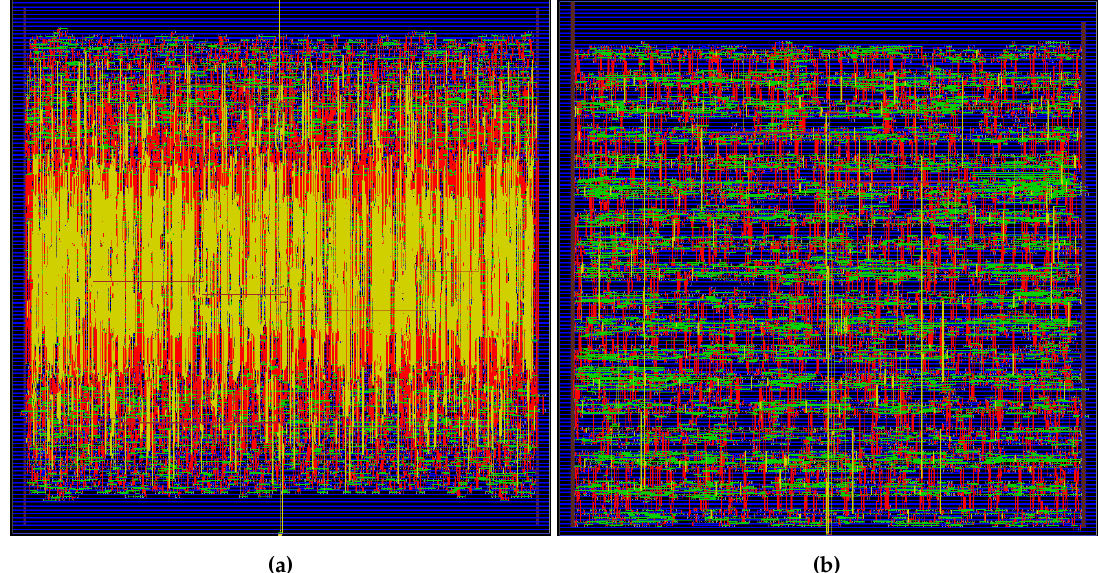
Figure 3. Routed 8 × 16 bit designs with a floorplan size of 250 µ m × 250 µ m. ( a ) 3-Block approach; ( b ) Proposed interleaved approach.